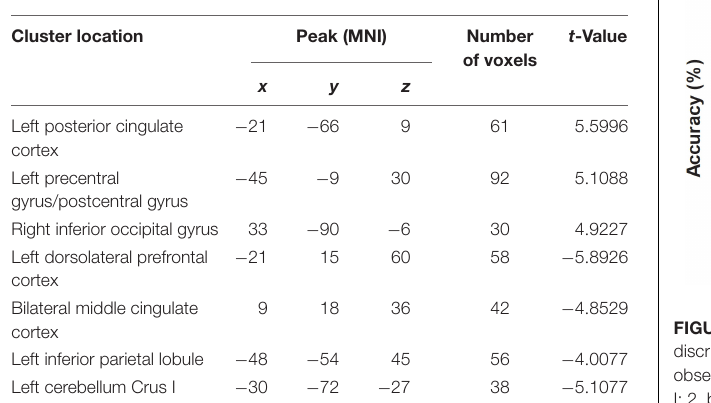
TABLE 2 | The differences of PAS scores between patients with OCD and HCs.